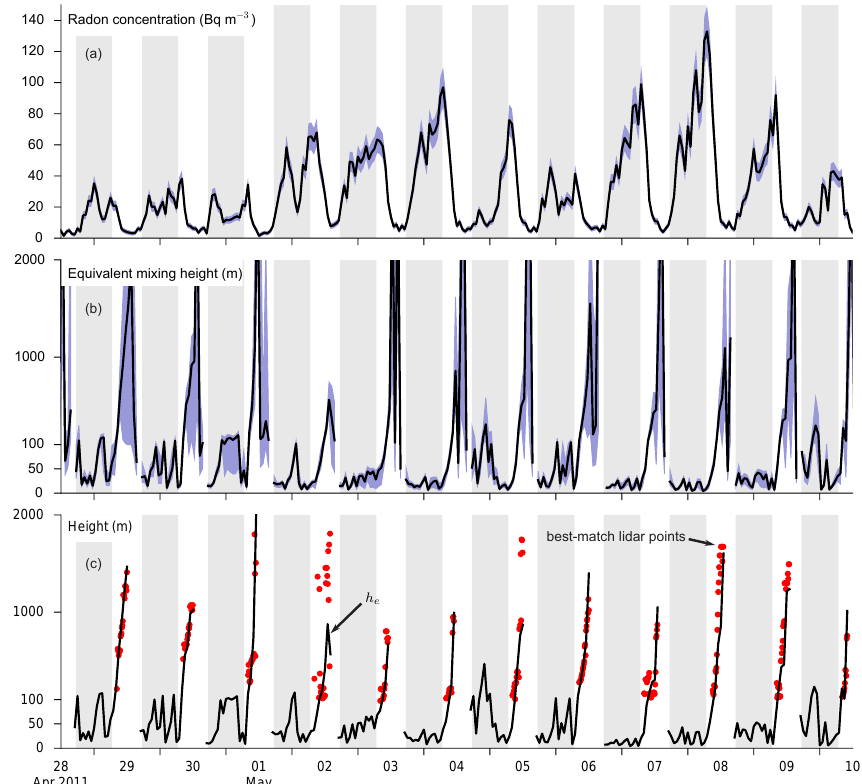
Fig. 4. Panel (a) : radon (shading indicates ± 1 standard deviation, approximately the 15th and 85th percentiles, of measurement uncertainty); (b) equivalent mixing height, h e (shading extends to the 15th and 85th percentiles of an ensemble of models), and (c) the best estimate of mixing height from lidar after merging with h e along with calibrated h e . Vertical shaded bars indicate night-time. The y-axes of (b) and (c) are magnified 5 × below